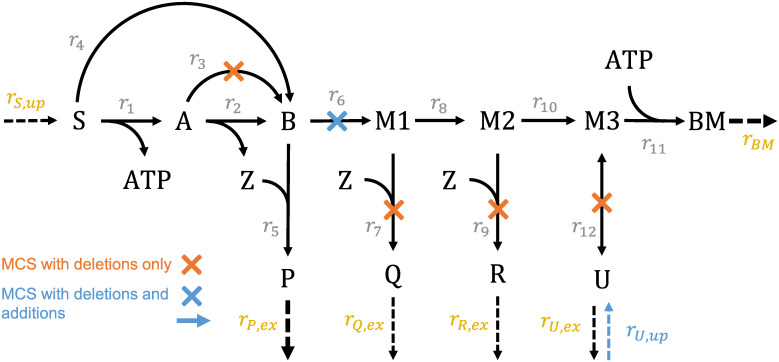
Example network illustrating substrate co-utilization.The wild-type strain that can be turned into a production host for the target product P, either by using substrate S and four knockouts (orange MCS) or by a co-utilization of S and U, which requires one deletion and the addition of the uptake reaction for U (blue MCS). Reactions with dashed arrows and yellow names indicate non-targetable exchange reactions.